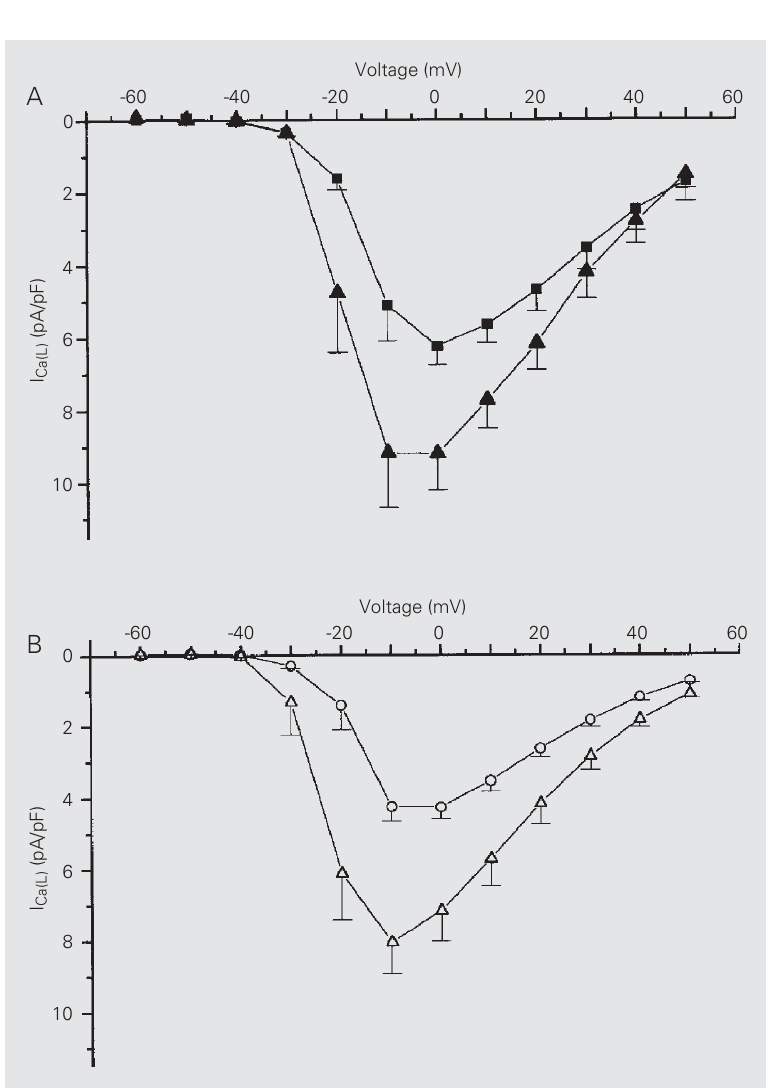
Figure 3. Effect of forskolin on L-type calcium current (I Ca(L) ). Forskolin (10 µM) added to the extracellular saline provoked similar increases in I Ca(L) density in both sham ( A , filled squares in the absence and filled triangles in the presence of forskolin) and postinfarction myocytes ( B , open circles in the absence and open triangles in the presence of forskolin). There was no significant difference in the mean increase of I Ca(L) induced by forskolin at any voltage in both groups. At -10 mV test voltage, the increases were 90.0 ± 12.9% (N = 4) in postinfarc- tion and 91.2 ± 27.2% (N = 5) in sham myocytes (P = 0.9, unpaired Student t